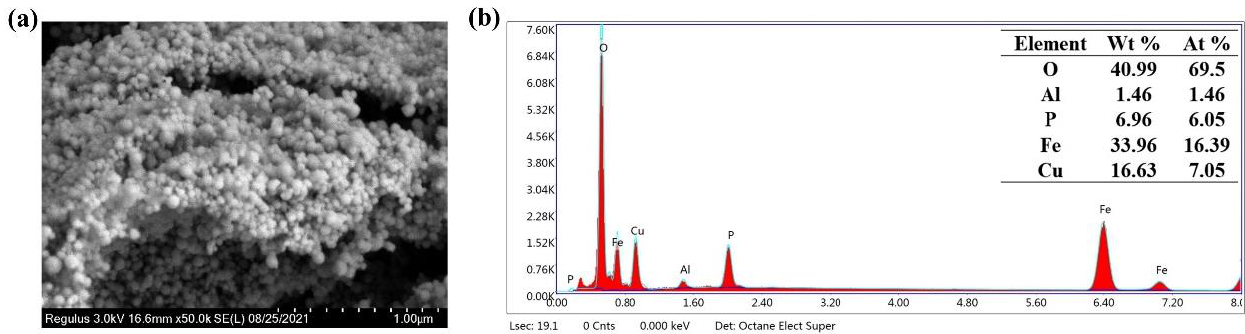
Figure 1. SEM image ( a ) and EDS spectroscopy ( b ) of CuFe 2 O 4 .